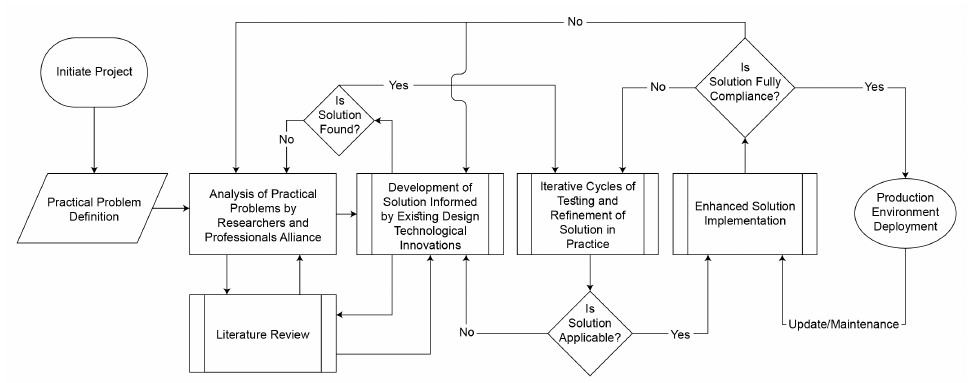
Figure 1. Research